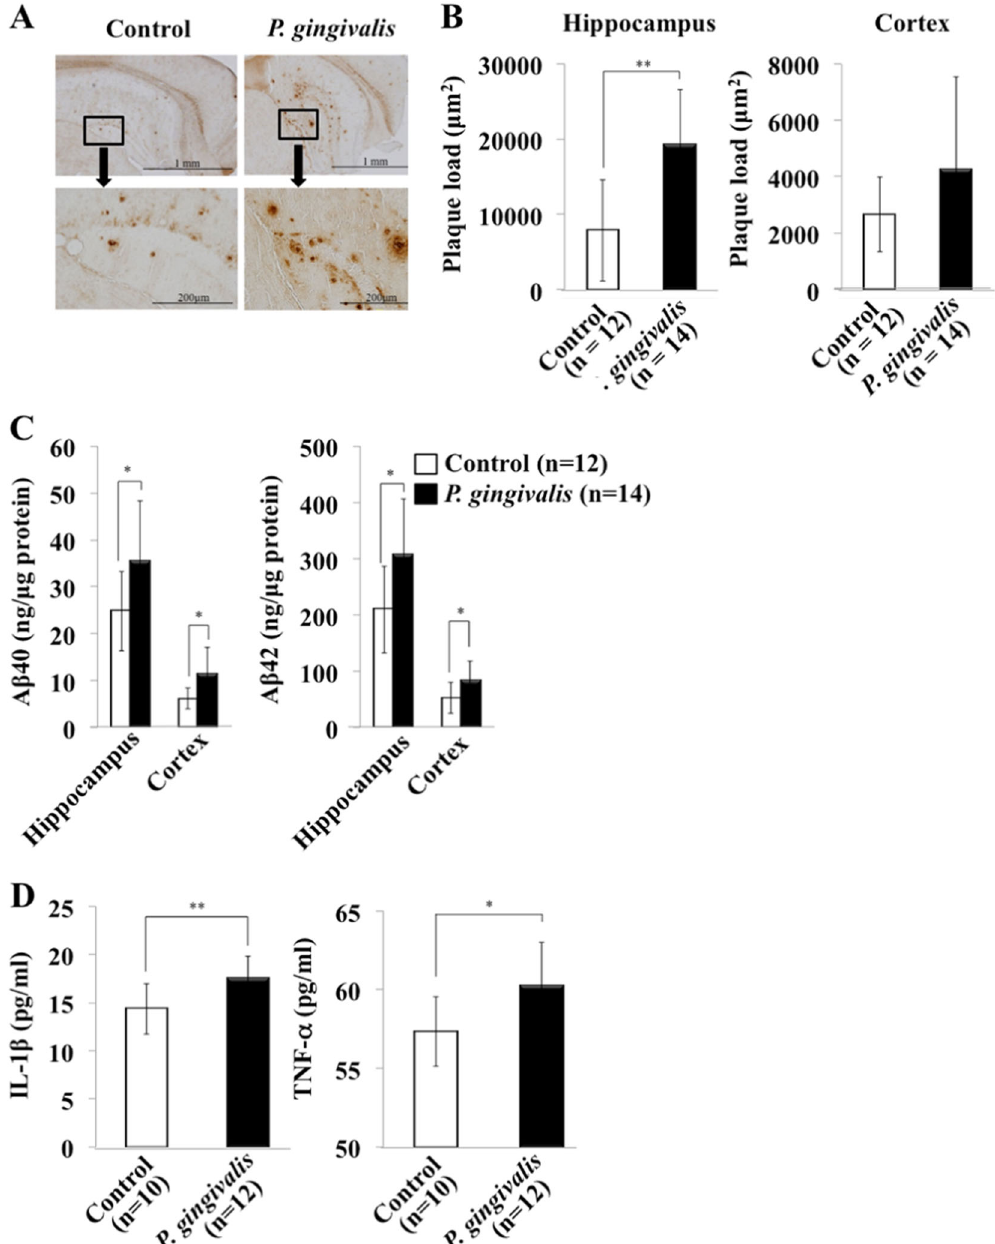
Fig. 3 Amyloid plaque deposition in the cortex and hippocampus of APP-Tg mice. a Immunostaining of A β in brain sections. b A β loads in brain sections. Results are expressed as means ± S.D., ** p < 0.01. c A β 40 and A β 42 in the cortex and hippocampus of P. gingivalis- infected APP- Tg mice. Concentrations of A β 40 and A β 42 in the extracts of brain were measured by ELISA. Control: Mice inoculated with CMC alone, P. gingivalis : Mice inoculated with CMC and P. gingivalis . Results are expressed as means ± S.D., * p < 0.05. d TNF- α and IL-1 β in the brain in P. gingivalis- infected APP-Tg mice. Amounts of TNF- α and IL-1 β in brain extracts were measured by ELISA. Results are expressed as means ± S.D., * p < 0.05, ** p <